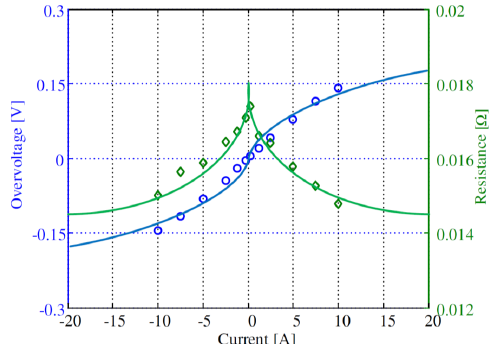
Figure 16. Measured non-linear dependence of the charge transfer resistance and of the corresponding over-voltage on the current of the LFP/C battery (note: positive current stands for charging).